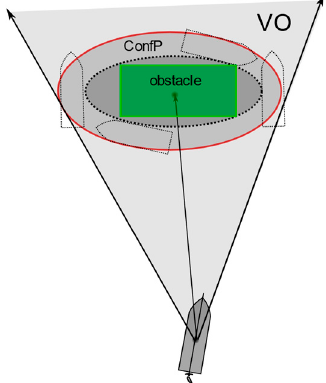
Figure 7. The proposed collision avoidance system for autonomous surface ships (( a ): geometry chart; and ( b ): the flowchart).